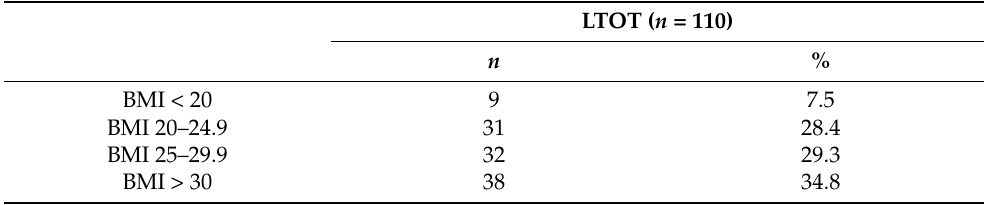
Table 1. Assessment of the nutritional status of patients with COPD treated with LTOT according to the Body Mass Index ( n = 110).